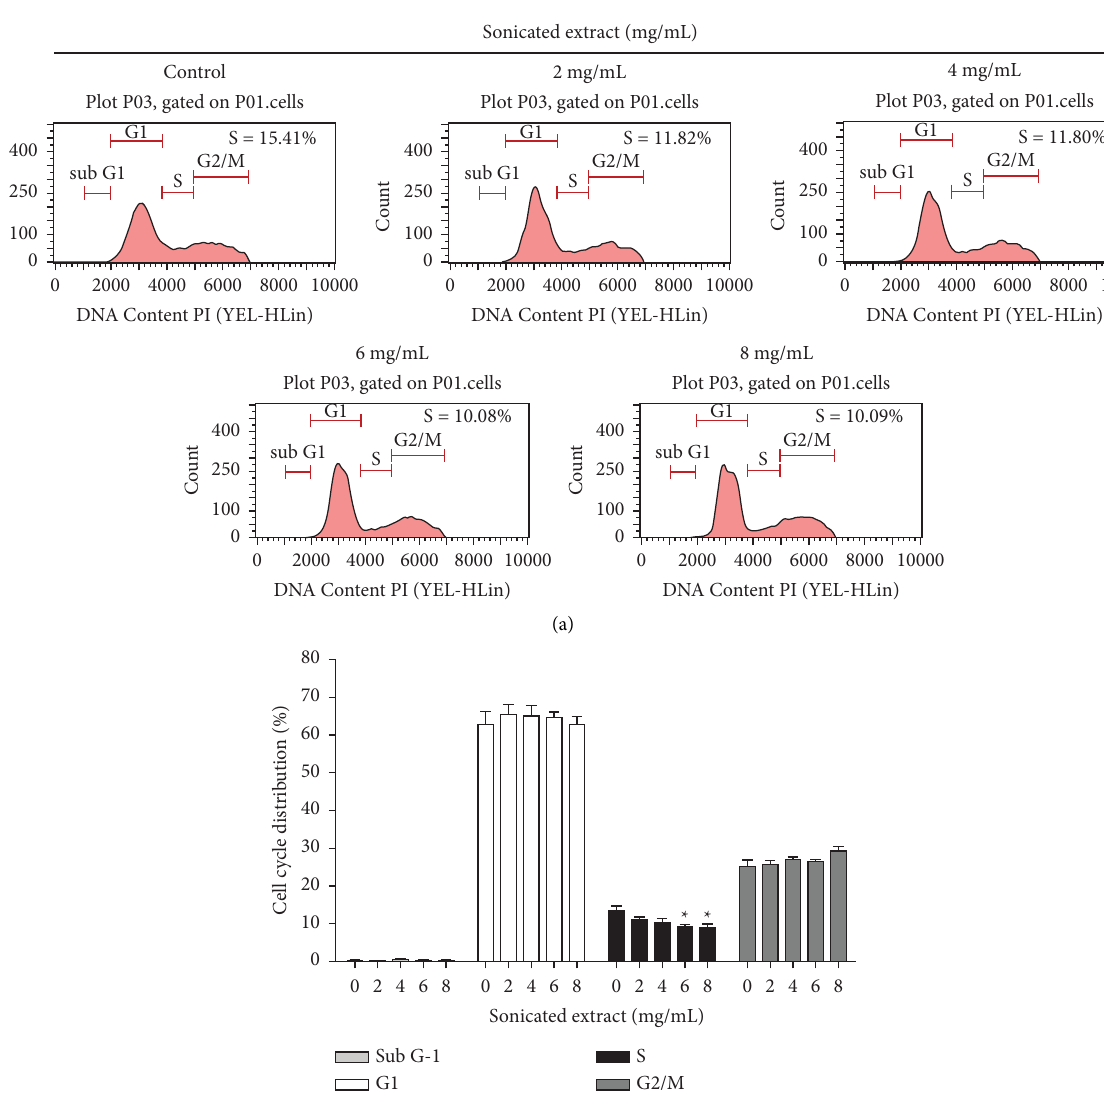
Figure 4: Cell cycle analysis in prostate cancer cells treated with sonicated extract. (a) PC-3cells were treated with sonicated extract for 24h, and cell cycle analysis was performed by fow cytometry using propidium iodide (PI) staining. (b) Te percentages of cells in sub-G1, G1, S, and G2/M phases are indicated. Data are presented as the means ± SEM ( n � 3). p < 0 . 05 ∗ was compared with the control group by one-way ANOVA (Dunnett’s